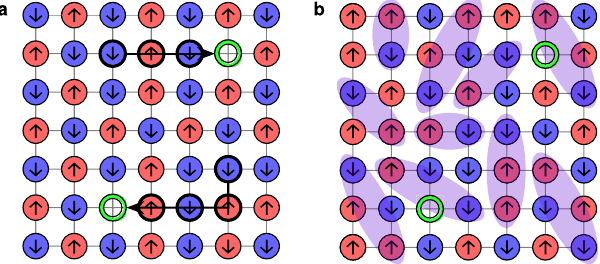
Fig. 2 Model effective theories of the 2D Fermi-Hubbard model. A cartoon depicting the features of two candidate theories approximating the low- T , low-doping limit of the Fermi-Hubbard model. Red, blue sites are spin-up, spin-down electrons respectively, while green circles represent holes. a Geometric string theory, showing two geometric strings in the presence of an antiferromagnetic background. Note that the propagation of the doped holes creates parallel line segments of aligned spins, perpendicular to the direction of the hole propagation. b π - fl ux theory, which describes a spin liquid of